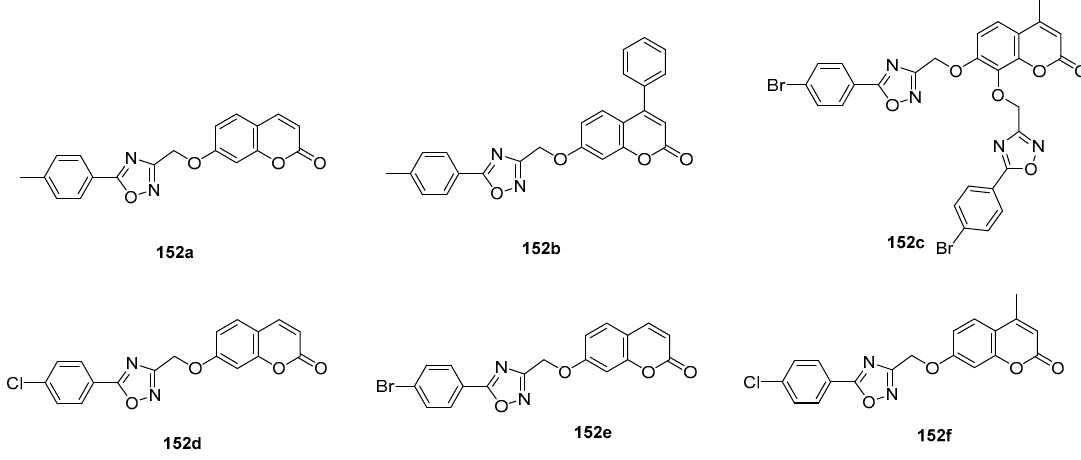
Figure 47. Chemical structure of compounds 152a–f.